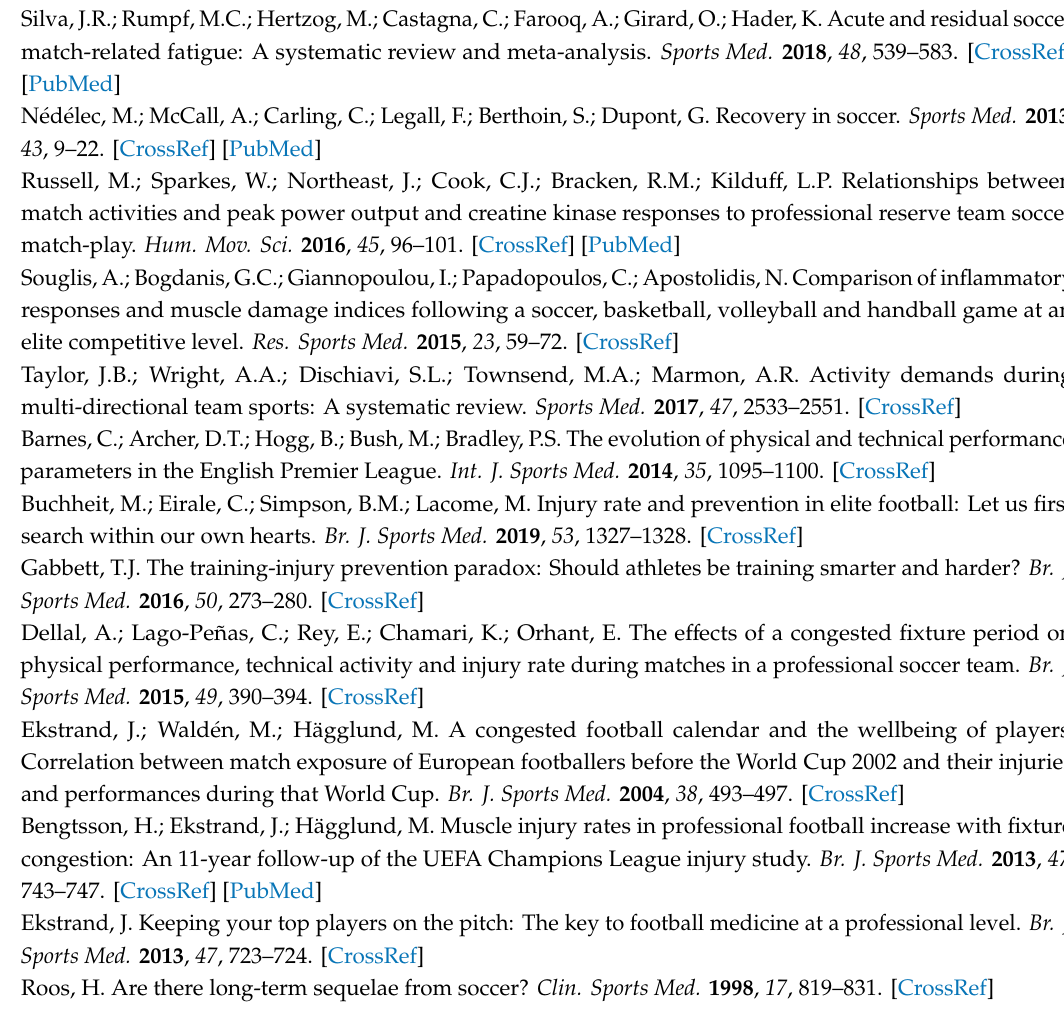
Table S1: Top four teams to obtain the number of games per season (2018–2019), international, men, elite of each